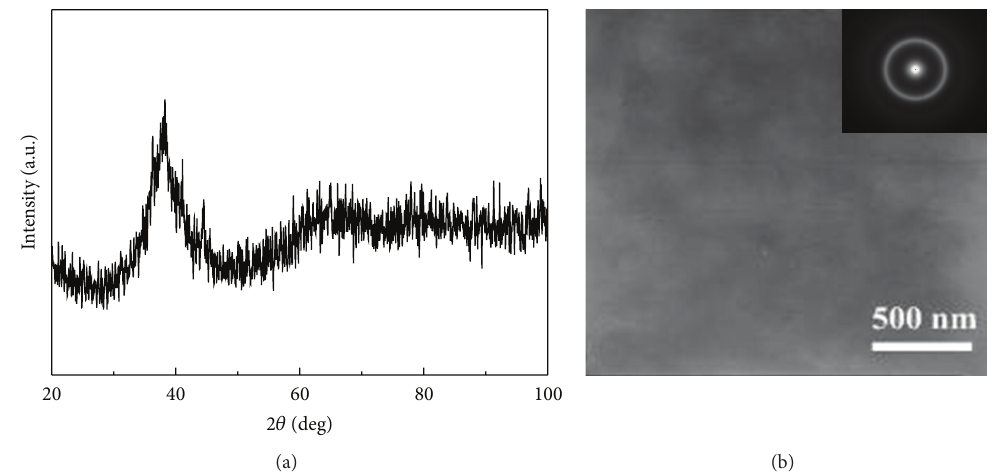
Figure 3: XRD pattern (a) and bright-field TEM image with corresponding SAED pattern (b) for location #1.